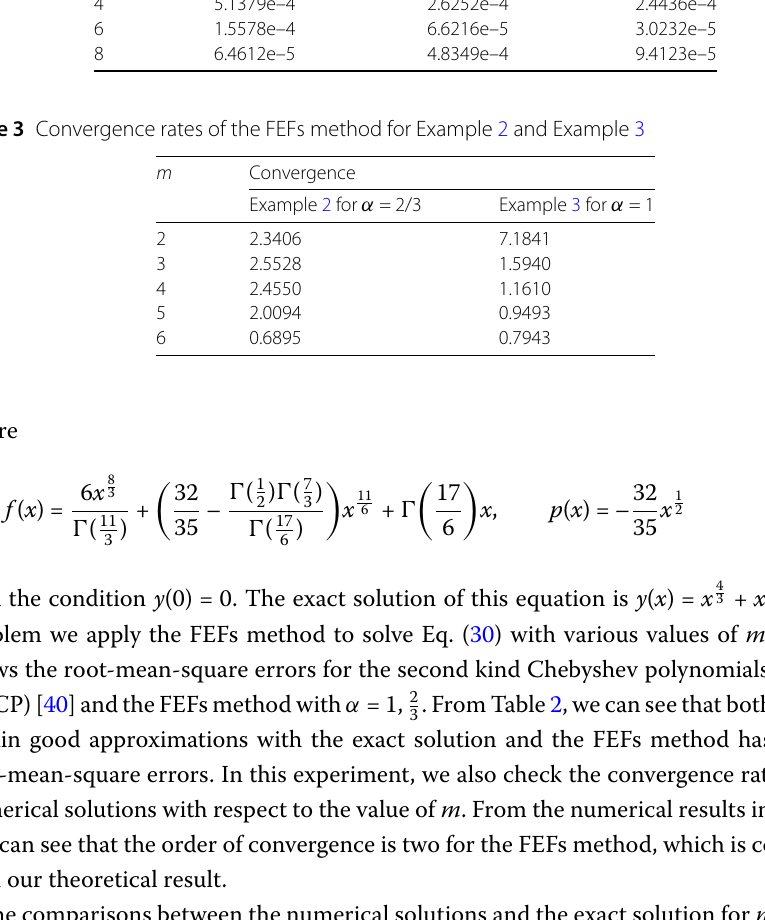
Table 2 The root-mean-square errors ξ m of the FEFs method and the SKCP method m SKCP method FEFs method α = 1